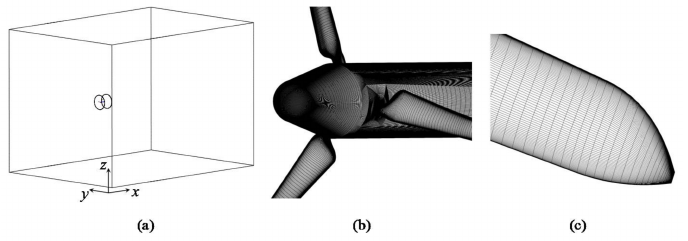
Figure 1. Schematic of the computational mesh: ( a ) outline of the computational domain; ( b ) blade root and nacelle surface mesh; ( c ) blade tip surface